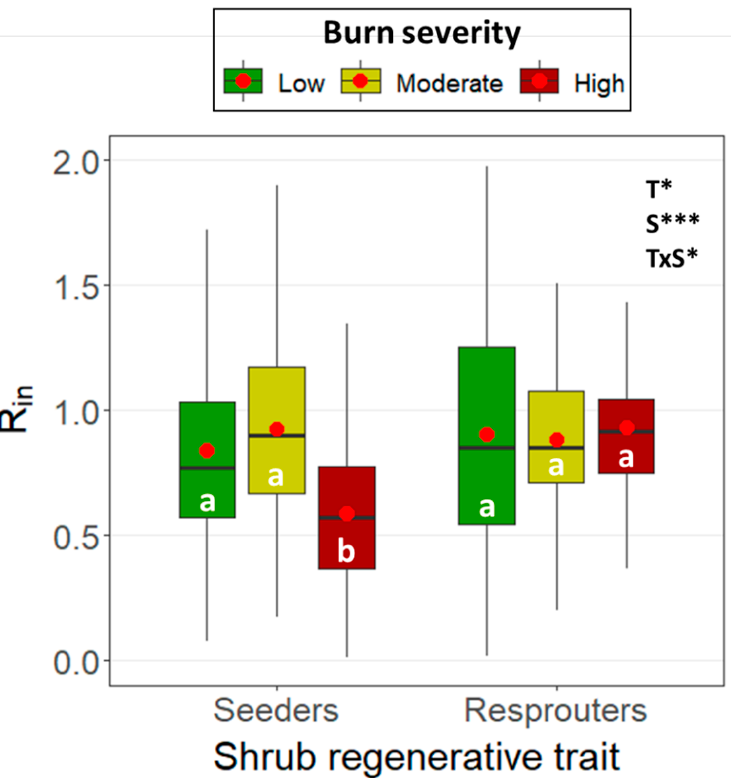
Figure 3. Boxplot showing the relationship between the impact-normalized resilience index ( R in ) and burn severity in shrubland plant communities dominated by facultative seeders species and resprouter species. Significance of R in predictors (regenerative trait: T; burn severity: S; T × S interaction) is represented as * ( p -value < 0.05), ** ( p -value < 0.01), and *** ( p -value < 0.001). Lowercase letters denote significant differences in R in at the 0.05 level between burn severity levels within each plant community.